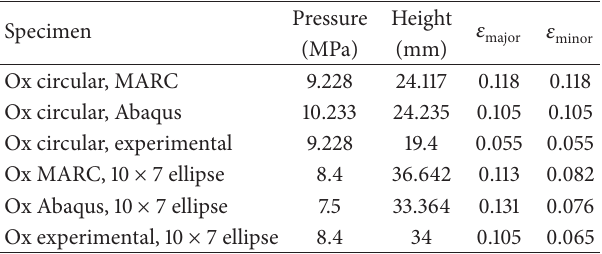
Table 4: Comparison between the height of the domes and the